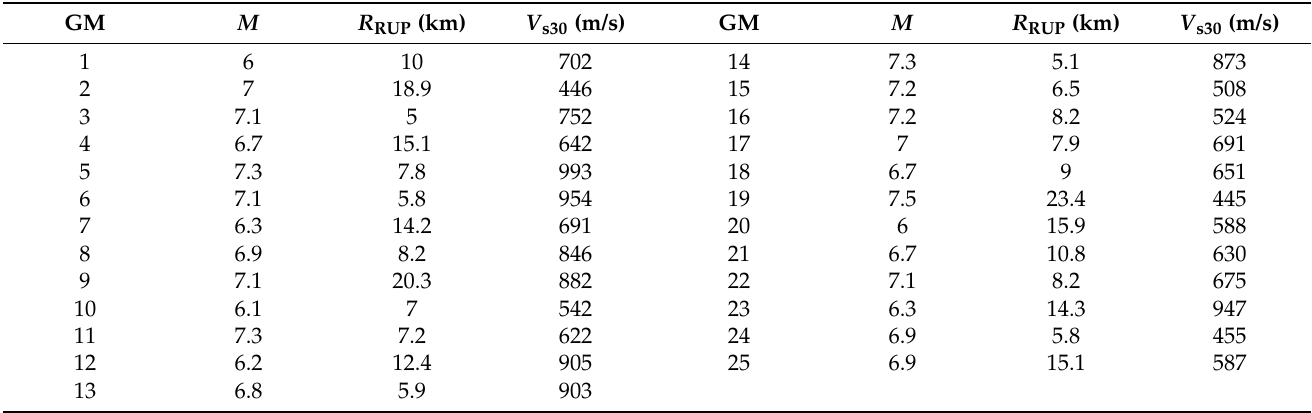
Figure 5. Time histories of a synthetic ground-motion pair. Table 3. Input parameters of the synthetic ground motions.